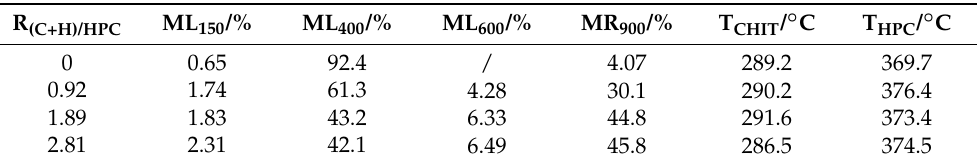
Table 4. The mass losses and residual masses at 900 ◦ C for pure HPC and nanocomposites determined